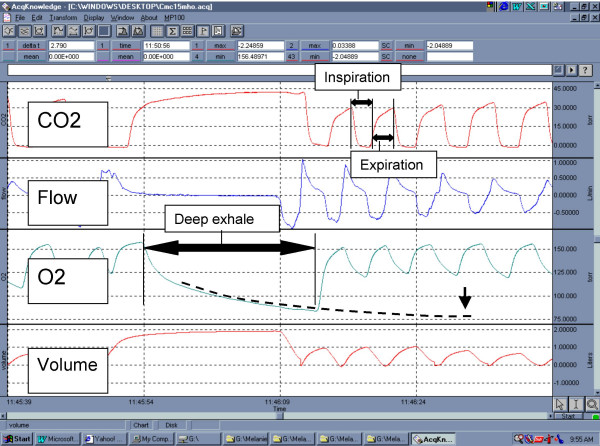
An example of the raw data that was analyzed from exhaled breath measurements. The third panel represents the partial pressure of expired oxygen. The long exhalation represents a voluntary deep exhalation, done on command as part of the data collection protocol. The superimposed dotted line hypothetically represents the regression equation where the zero slope portion, denoted by the arrow, represents the steady-state estimate of the partial pressure of oxygen in mixed venous blood. Inspiratory, expiratory and deep exhale cycles are annotated on the figure. CO2 – carbon dioxide; Vol – volume; O2 – oxygen.